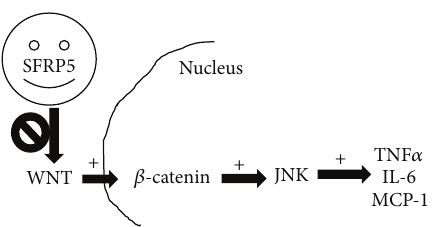
Figure 4: Signaling pathway of SFRP5, a decoy for WNT signaling pathway, which further activates 𝛽 -catenin and then JNK. Activated JNK promotes proinflammatory cytokines TNF 𝛼 , IL-6, and MCP-1. Under obese state, the production of SFRP5 was reduced and thus the decoying effect was weak, which is translated into the increased proinflammation and insulin